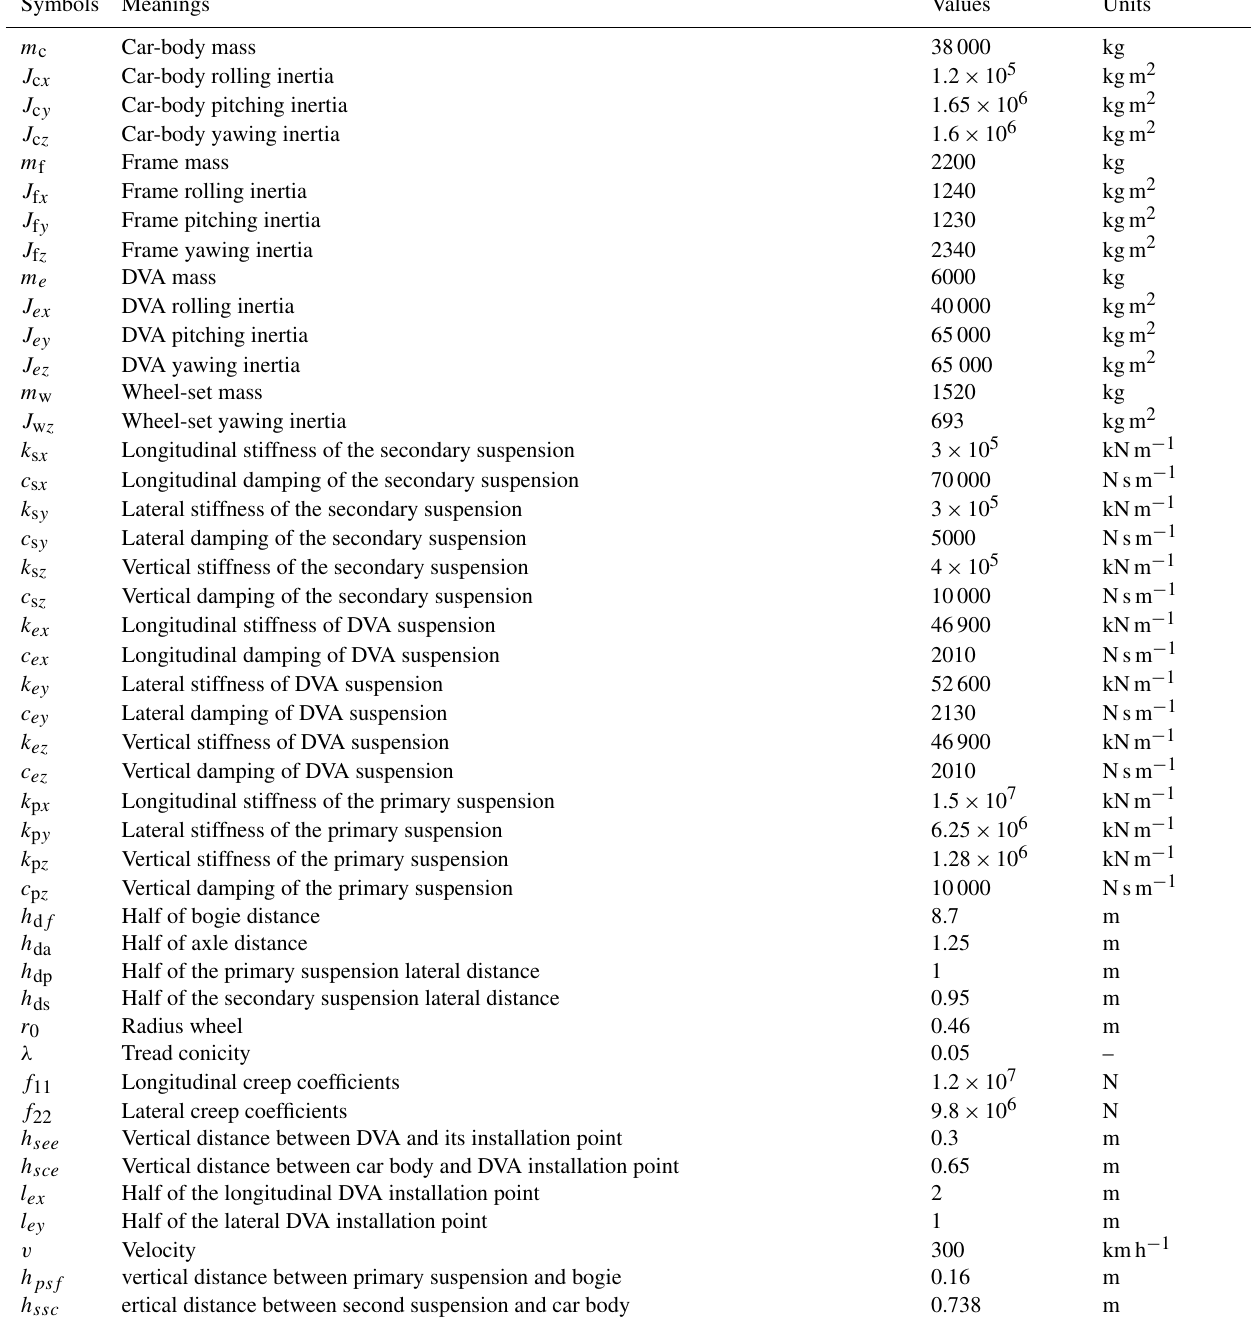
Table A2. Parameters for the high-speed train dynamic model. Symbols Meanings Values Units m c Car-body